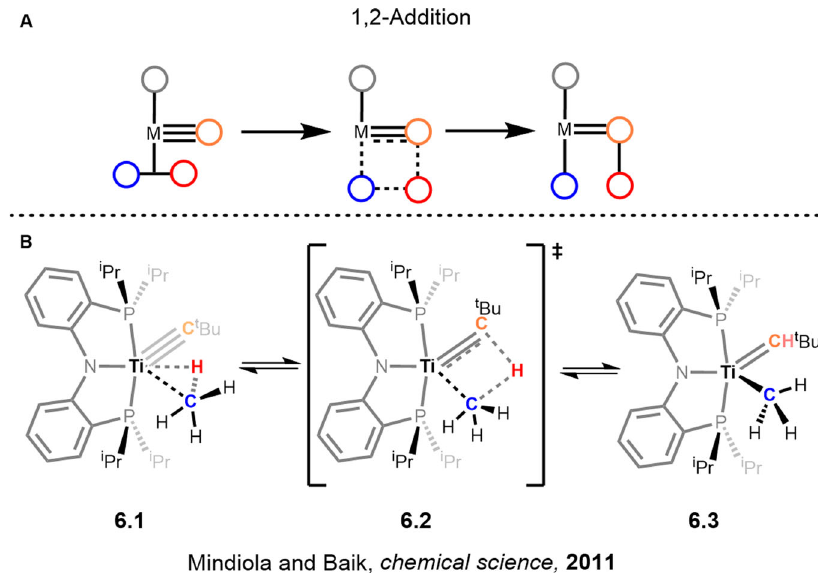
Fig. 7 1,2-Addition mechanism. A Simpli fi ed reaction pathway. B Reaction pathway showing the transition state of the 1,2-addition of a C-H bond to a titanium alkylidyne complex. Alkylidene and imido complexes follow the same transition